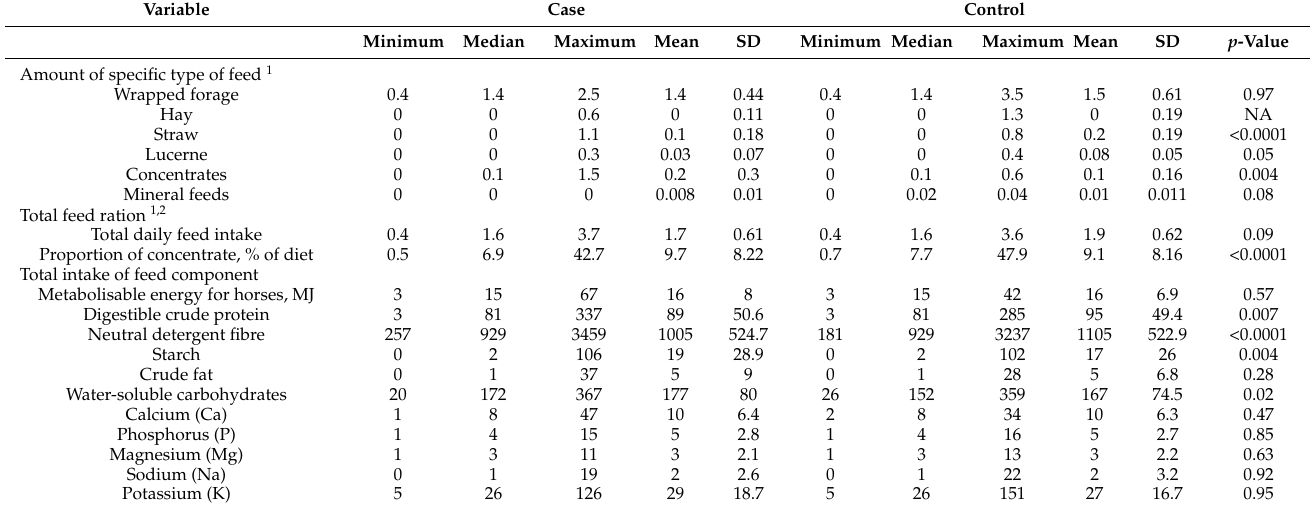
Amount of specific type of feed 1 Wrapped